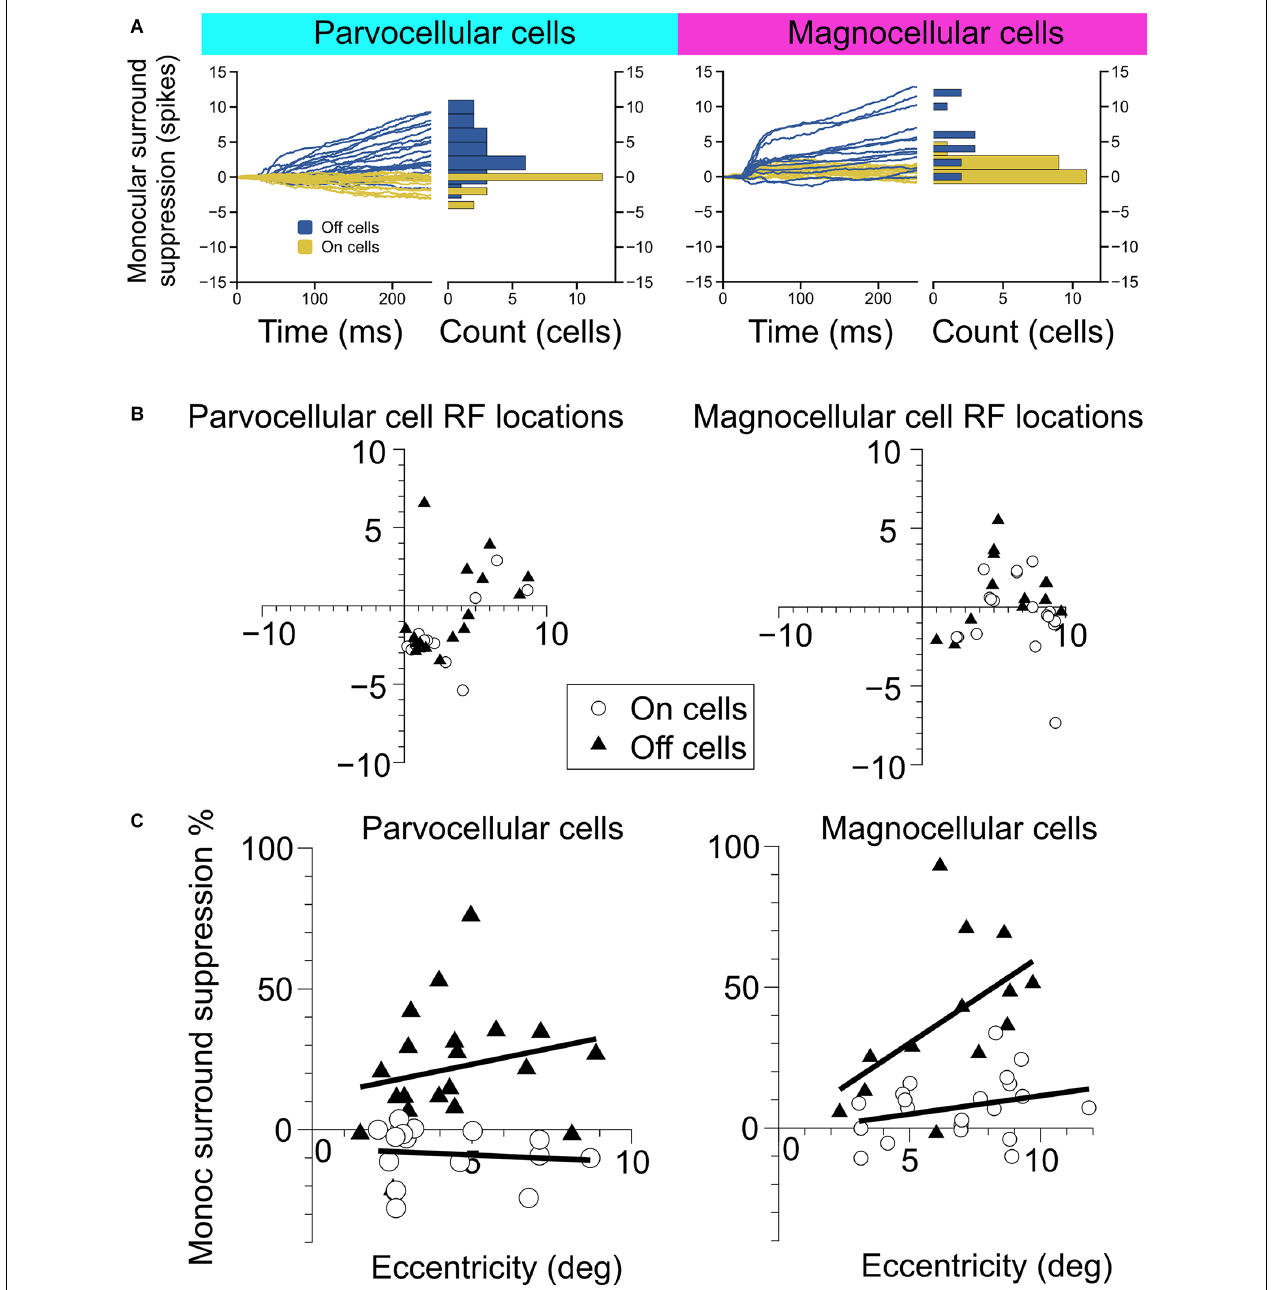
FIGURE 2 | Measurement of monocular surround suppression in On-cells and Off-cells of the parvocellular and magnocellular pathways. (A) The cumulative difference between spikes elicited by an optimally-sized monocular grating and spikes elicited by a large monocular grating. Histograms show the total difference in the number of spikes elicited by the stimuli. Off cells displayed statistically greater monocular surround suppression than On cells in both the parvocellular and magnocellular groupings. (B) Receptive field location of cell recordings in this experiment. (C) Surround suppression as a function of receptive field eccentricity in parvocellular and magnocellular cells. In both cell groups, Off cells showed greater monocular surround suppression than On cells. Bold lines depict linear fits to On cell and Off cell surround suppression in relation to receptive field